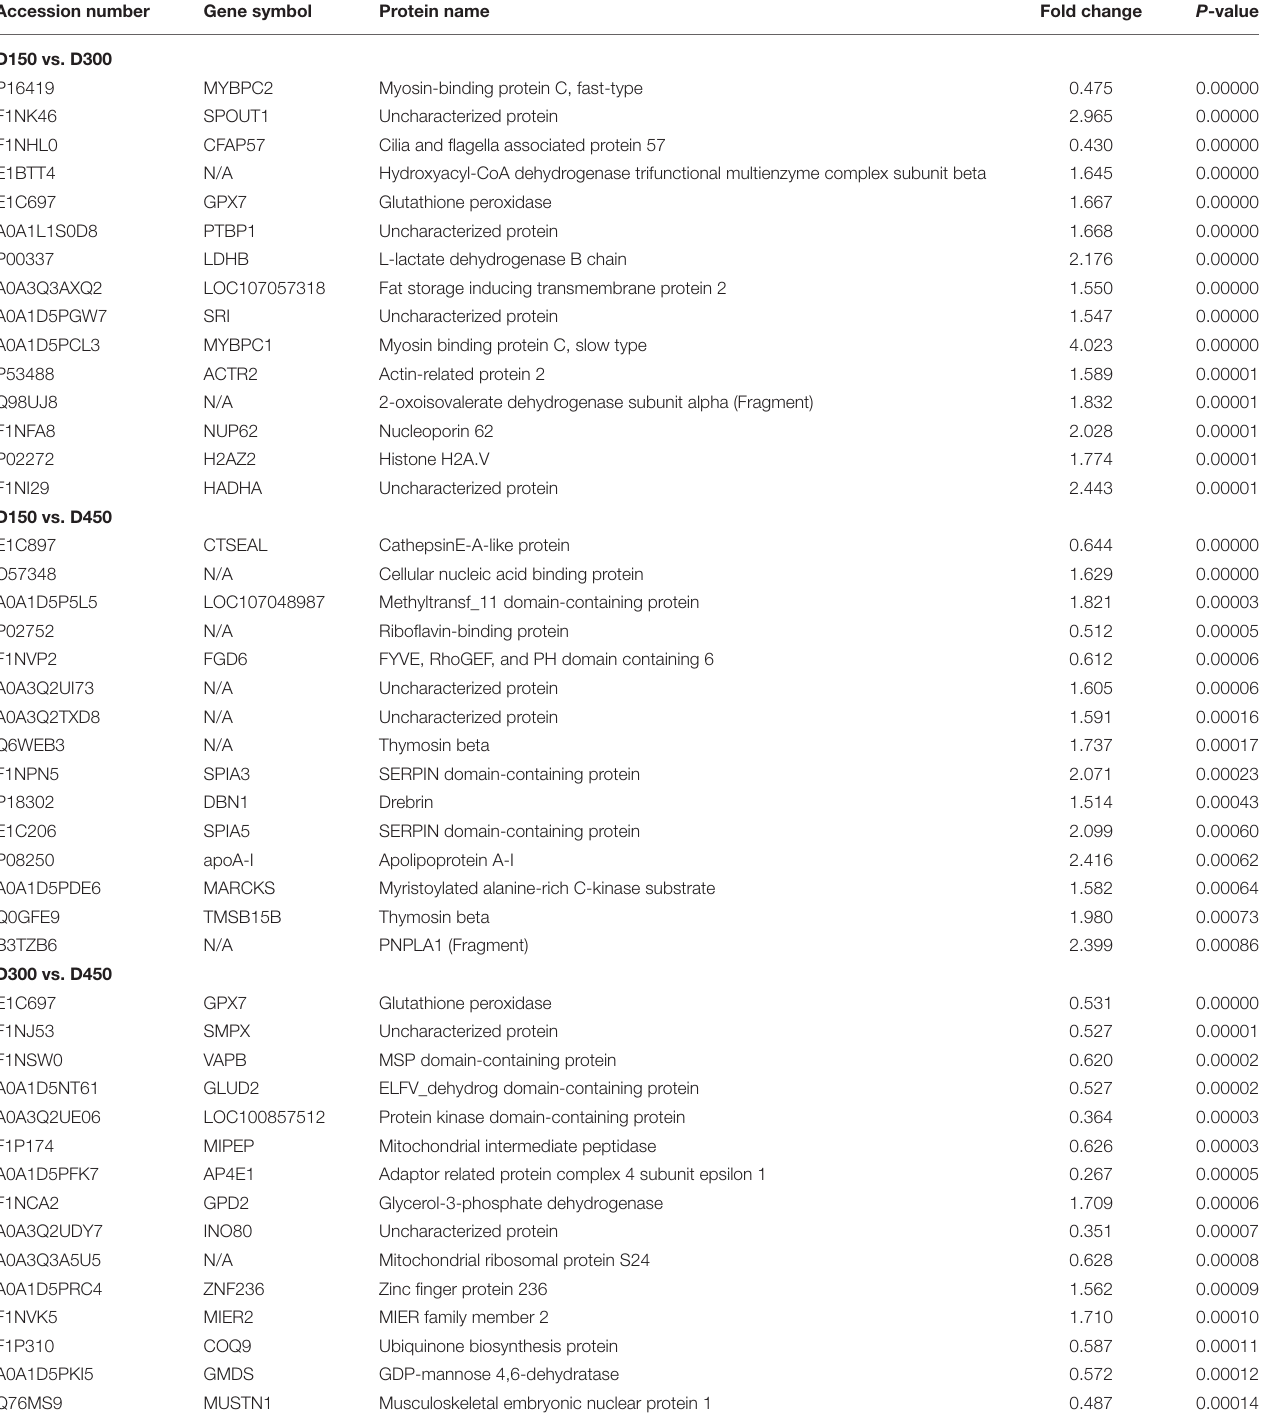
TABLE 3 | The top 15 differentially expressed proteins in three comparison groups (D150 vs. D300, D300 vs. D450, and D150 vs.